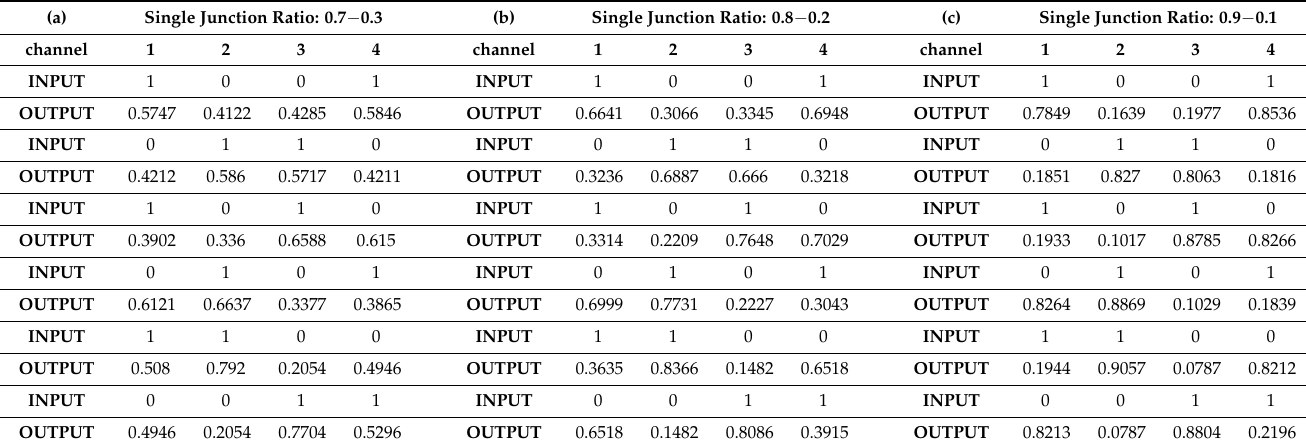
Table 3. Results of the simulation outputs of the mathematical model for 2-digit, 4-bit numbers and for different SJR values: (a) SJR = 0.7 − 0.3, (b) SJR = 0.8 − 0.2, and (c) SJR = 0.9 −